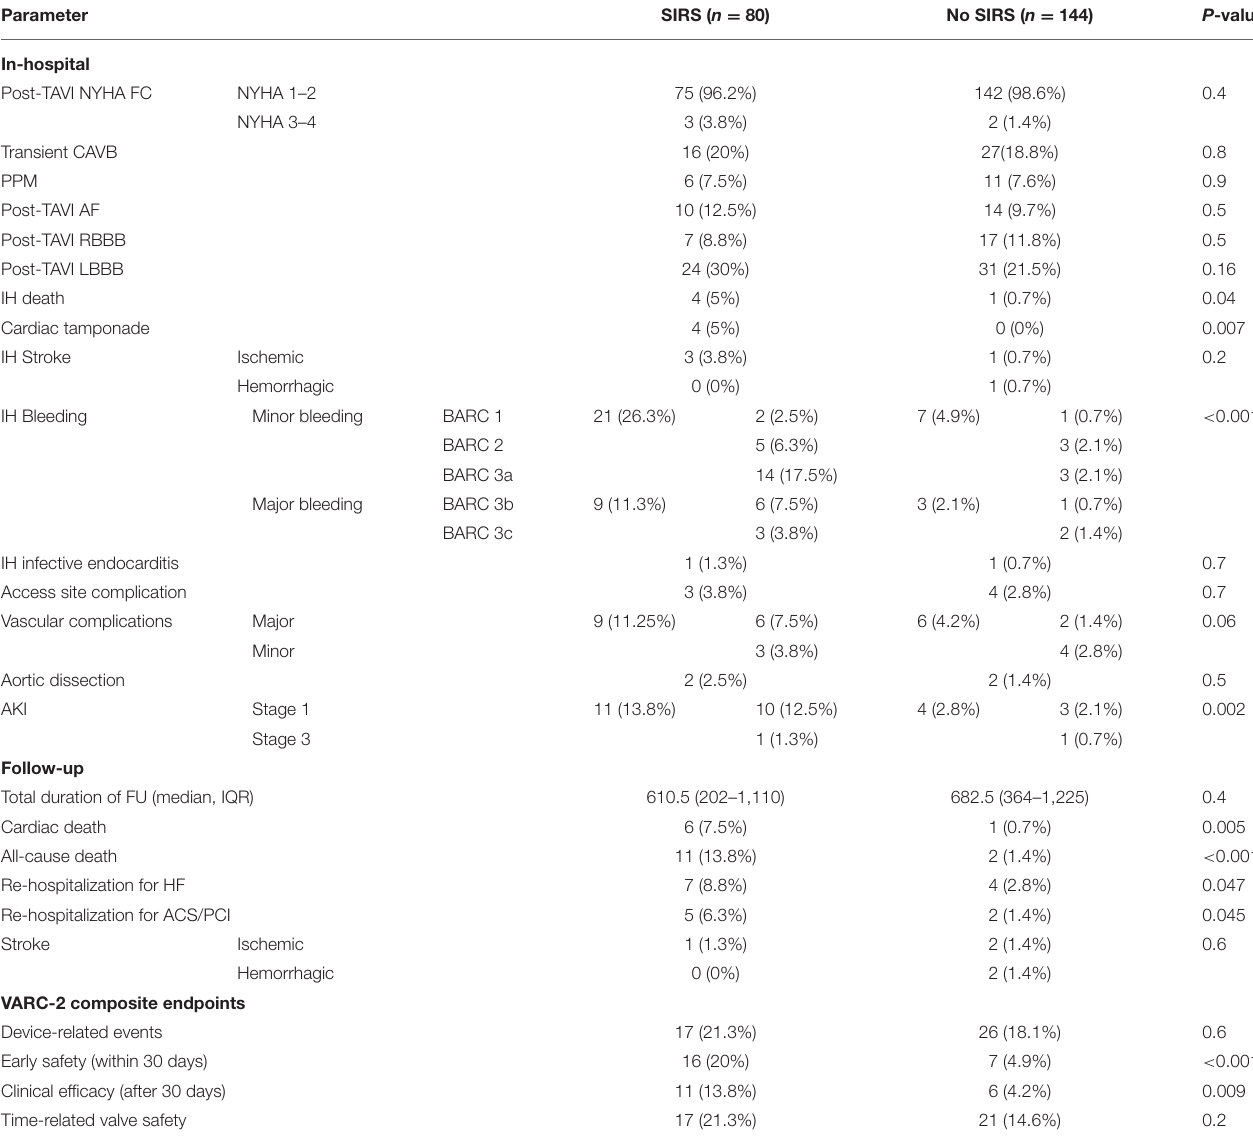
TABLE 7 | In-hospital and follow-up clinical outcomes. Parameter SIRS ( n =